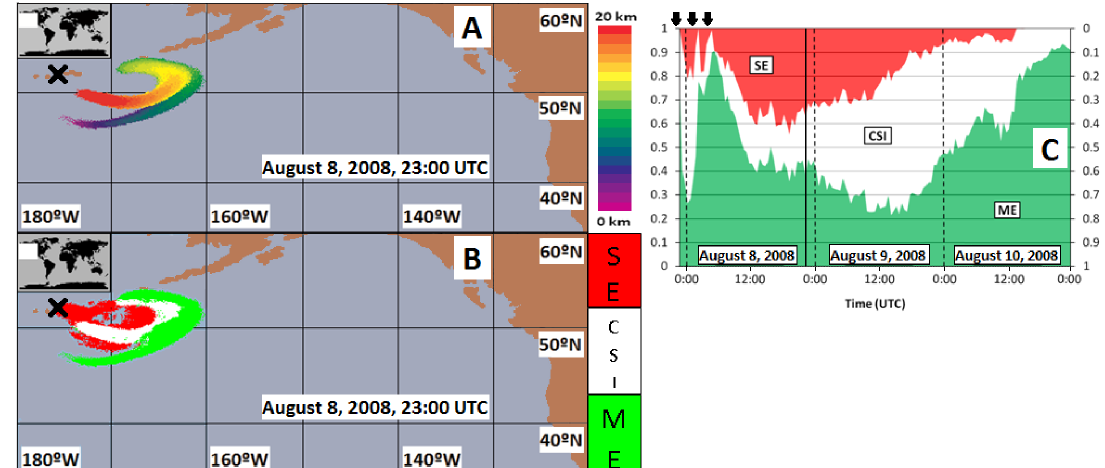
Figure 1: Location of the Kasatochi volcano in the Alaskan Aleutian Islands (black cross). (A) Snapshot from the results of the Puff run from the Kasatochi eruption in 2008. The color-coding is based on the ash height. (B) SE, CSI and ME values corresponding to the Puff scene in (A). Note that the ME values covers the lower part of the cloud, approximately up to 10 km above sea level.(C) Development of SE, CSI, and ME values over the course of the whole eruption. Towards the end, ME dominates and SE decreases to 0.The timing of S and B is highlighted by the solid black line. Arrows indicate the onset of different events as described by Waythomas et al.